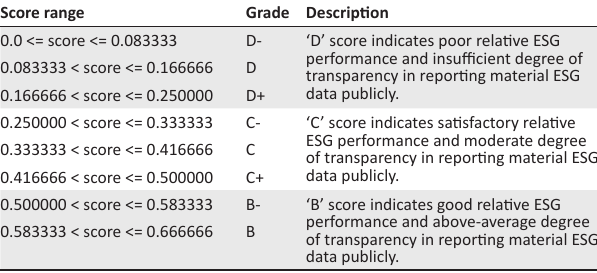
TABLE 1-A1: Environmental, social and governance score conversion between percentage and letter grades. Score